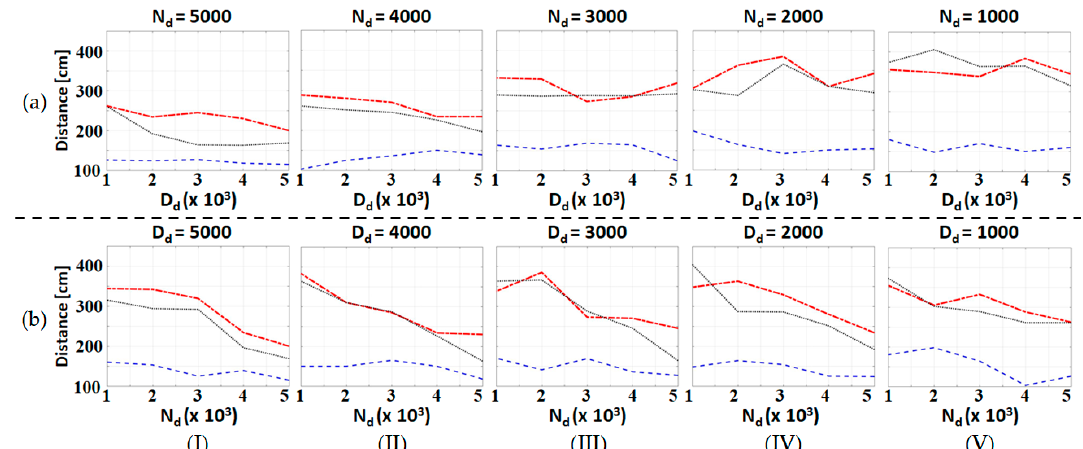
Figure 10. Plot of THE walking distance for a series of experiments with different admittance parameters: ( a ) N d is fixed and D d varies; and ( b ) D d is fixed and N d varies. The red dot-dashed line, blue dashed line and the black dotted line represent the data of Subject 1, Subject 2 and Subject 3, respectively.